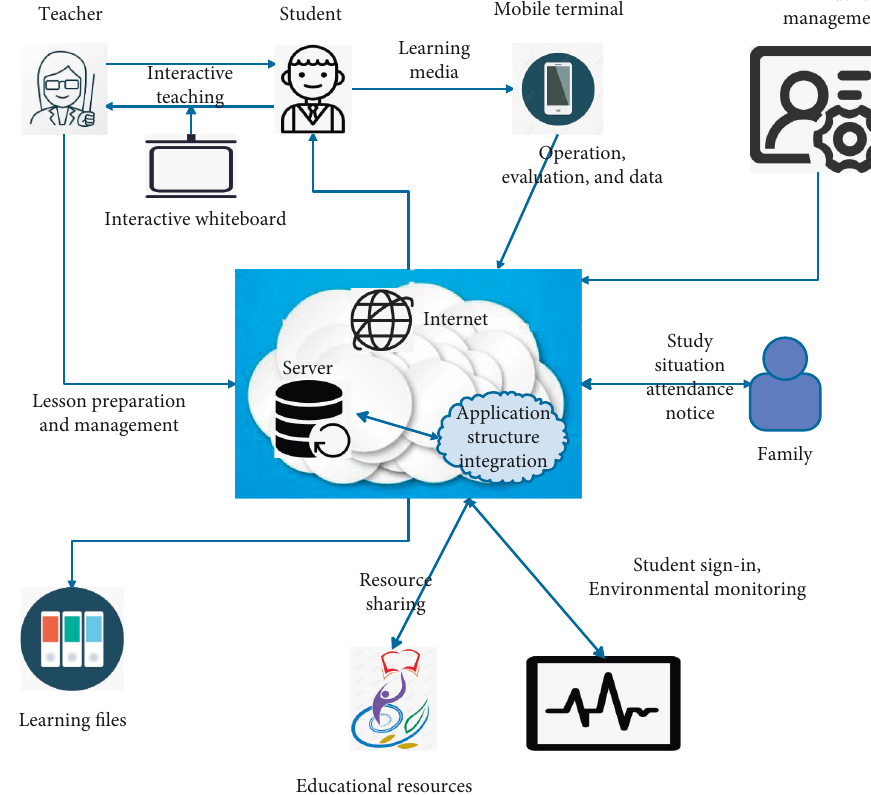
Figure 9: English online interactive teaching system.